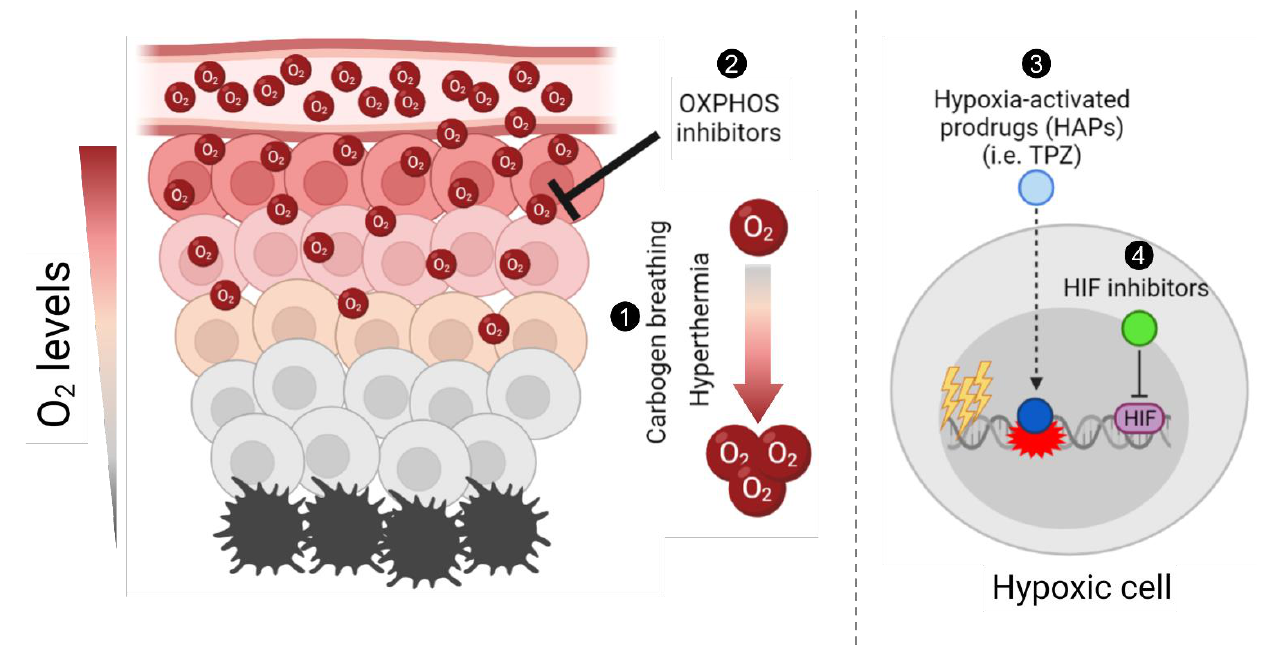
Figure 1. Schematic summary of different approaches to target tumour hypoxia. Briefly, (1) carbogen breathing and hyperthermia aim to increase the overall oxygen concentration in tumours, enhancing radiosensitisation; (2) Oxidative phosphorylation (OXPHOS) inhibitors target mitochondrial metabolism in well-oxygenated cells to promote an increase and diffusion of the overall oxygen into hypoxic regions and enhance radiation-induced damage; (3) hypoxia-activated prodrugs (HAPs), such as tirapazamine (TPZ), are reduced into their active cytotoxic form in hypoxic cells; and (4) the hypoxia-inducible factor (HIF) inhibitors aim to inhibit the hypoxia-induced activation of HIF, hence selectively targeting hypoxic cells. The figure was generated using Biorender.com (Accessed on 21 October 2021).